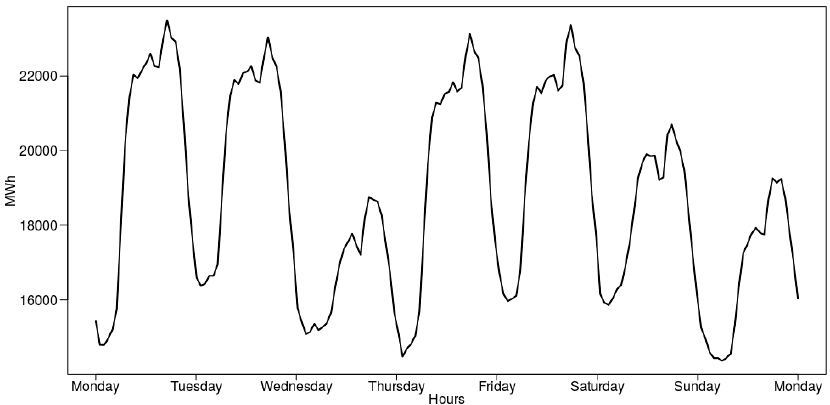
Figure 1. Hourly load data for Poland from 1 January 2015 to 31 December 2015.